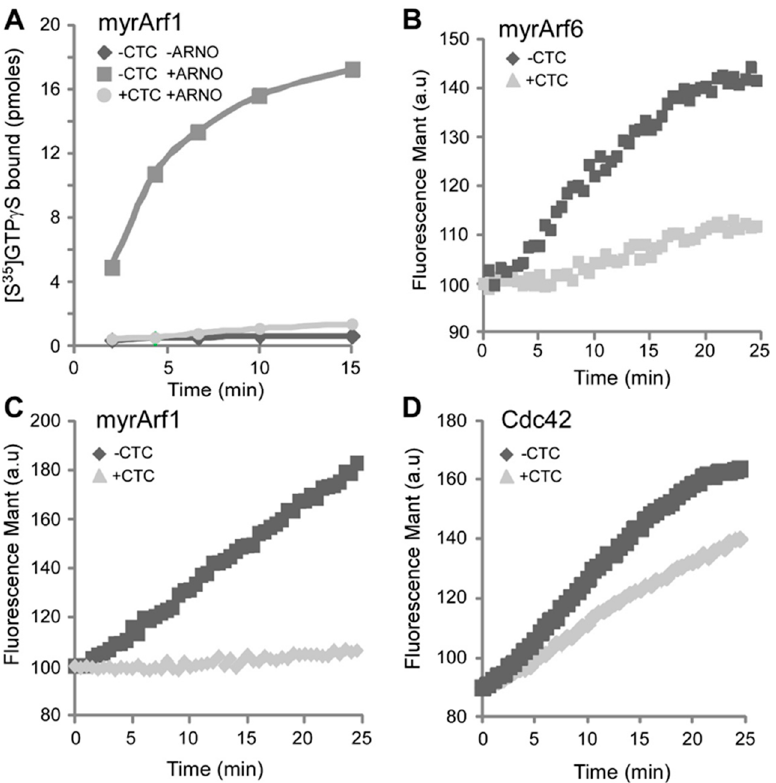
Figure 2. CTC is a specific inhibitor of Arf GTP loading in vitro. ( A ) GTP γ S 35 (10 µM) loading on myrArf1 (2 µM) was measured at 22 °C in the presence of 0.4 g/L azolectin with or without Arno (4 nM) and CTC (100 µM). ( B) mant-GTP (5 µM) loading on myrArf6 (2.5 µM) was done at 37 °C in the presence of 0.4 g/L azolectin with or without CTC (100 µM). ( C ) mant-GTP (5 µM) loading on myrArf1 (2.5 µM) was done at 37 °C in the presence of 0.4 g/L azolectin with or without CTC (100 µM). ( D ) mant-GTP (5 µM) loading on Cdc42 (2 µM) was done at 22 °C in the presence of 0.4 g/L azolectin with or without CTC (100 µM).